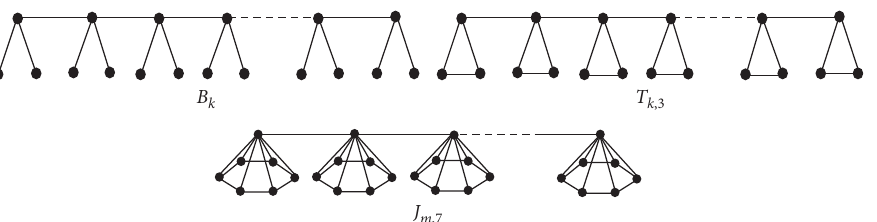
Figure 5: The graphs B